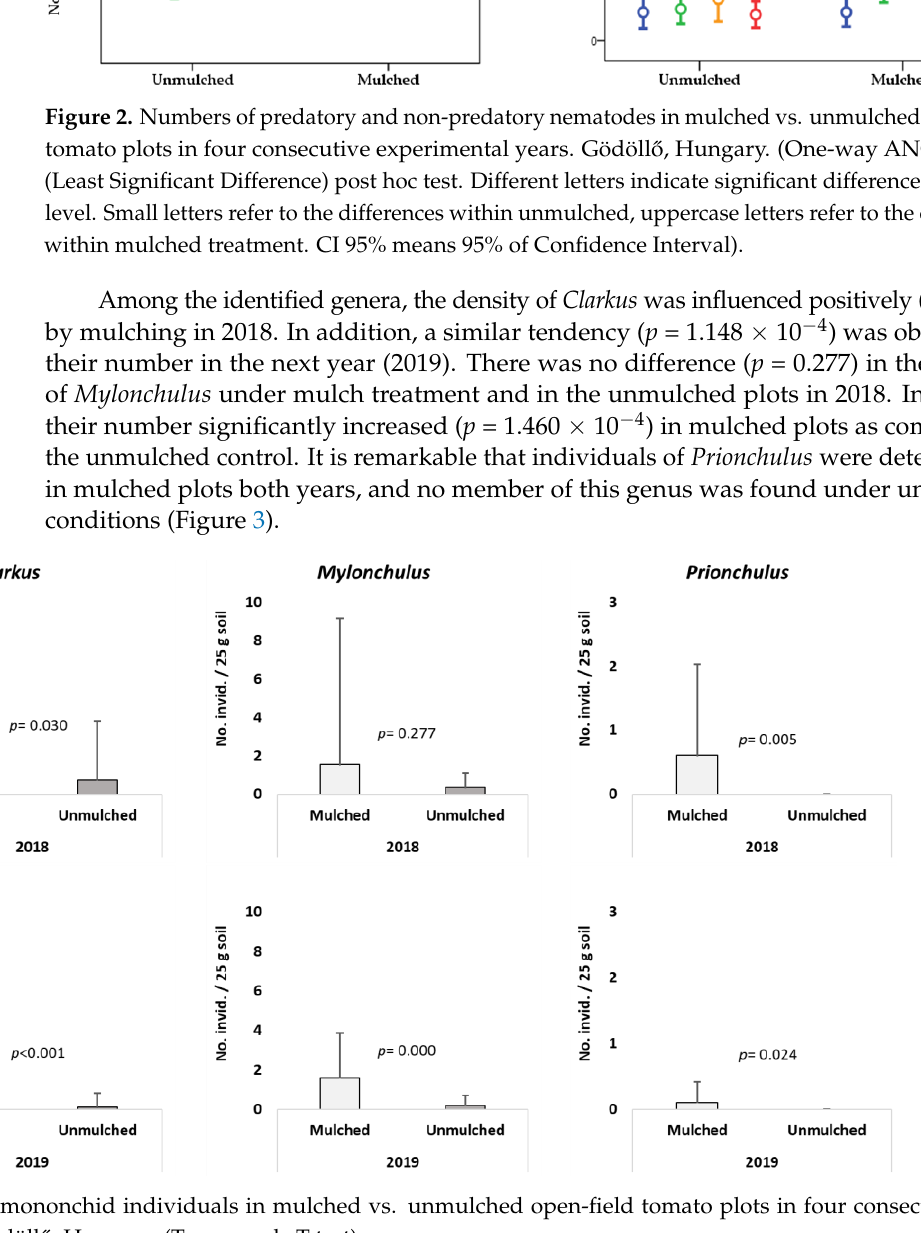
jpuri (Figure A1), Mylonchulus brachyuris Butschli (Figure A2), and Prionchulus